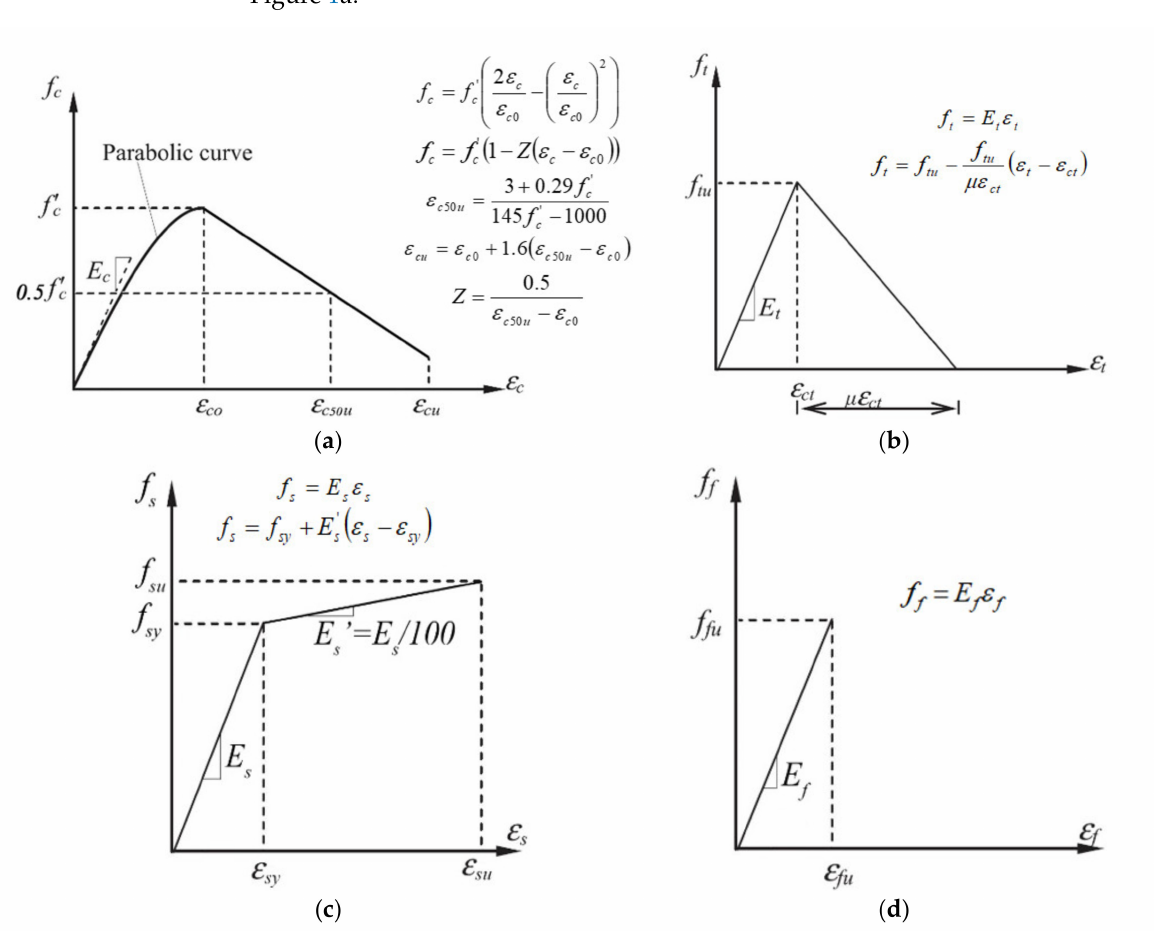
Figure 1. Stress–strain relationships: ( a ) concrete in compression; ( b ) concrete in tension; ( c ) internal steel reinforcement; ( d ) external strengthening